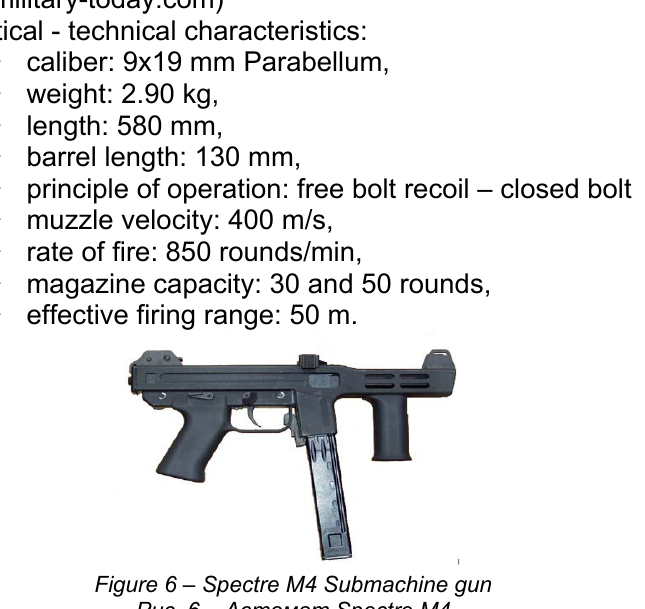
Figure 6 – Spectre M4 Submachine gun Рис . 6 – Автомат Spectre M4 Слика 6 – Аутомат Spectre